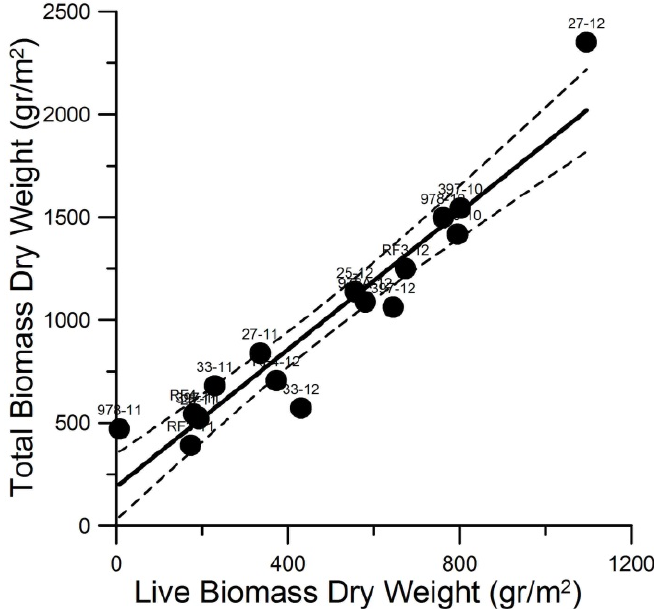
Figure 2. Total Biomass Dry Weight = 1.67 × Live Biomass Dry Weight + 190.28, R 2 = 0.91, MSE = 26,716.40 (gr/m 2 ) ( n = 17). Dashed line represents the 95% confidence limits. For data and site labels refer to Table